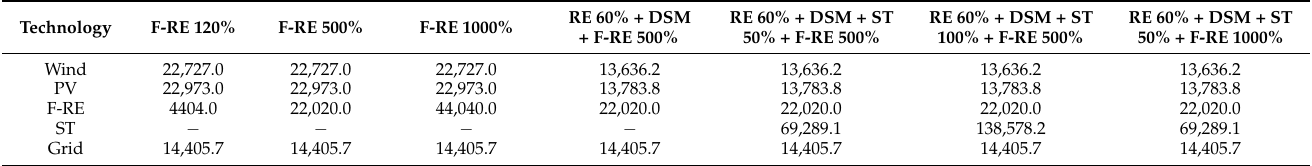
Table A24. Installed capacities in kW of the BioMAX scenarios.